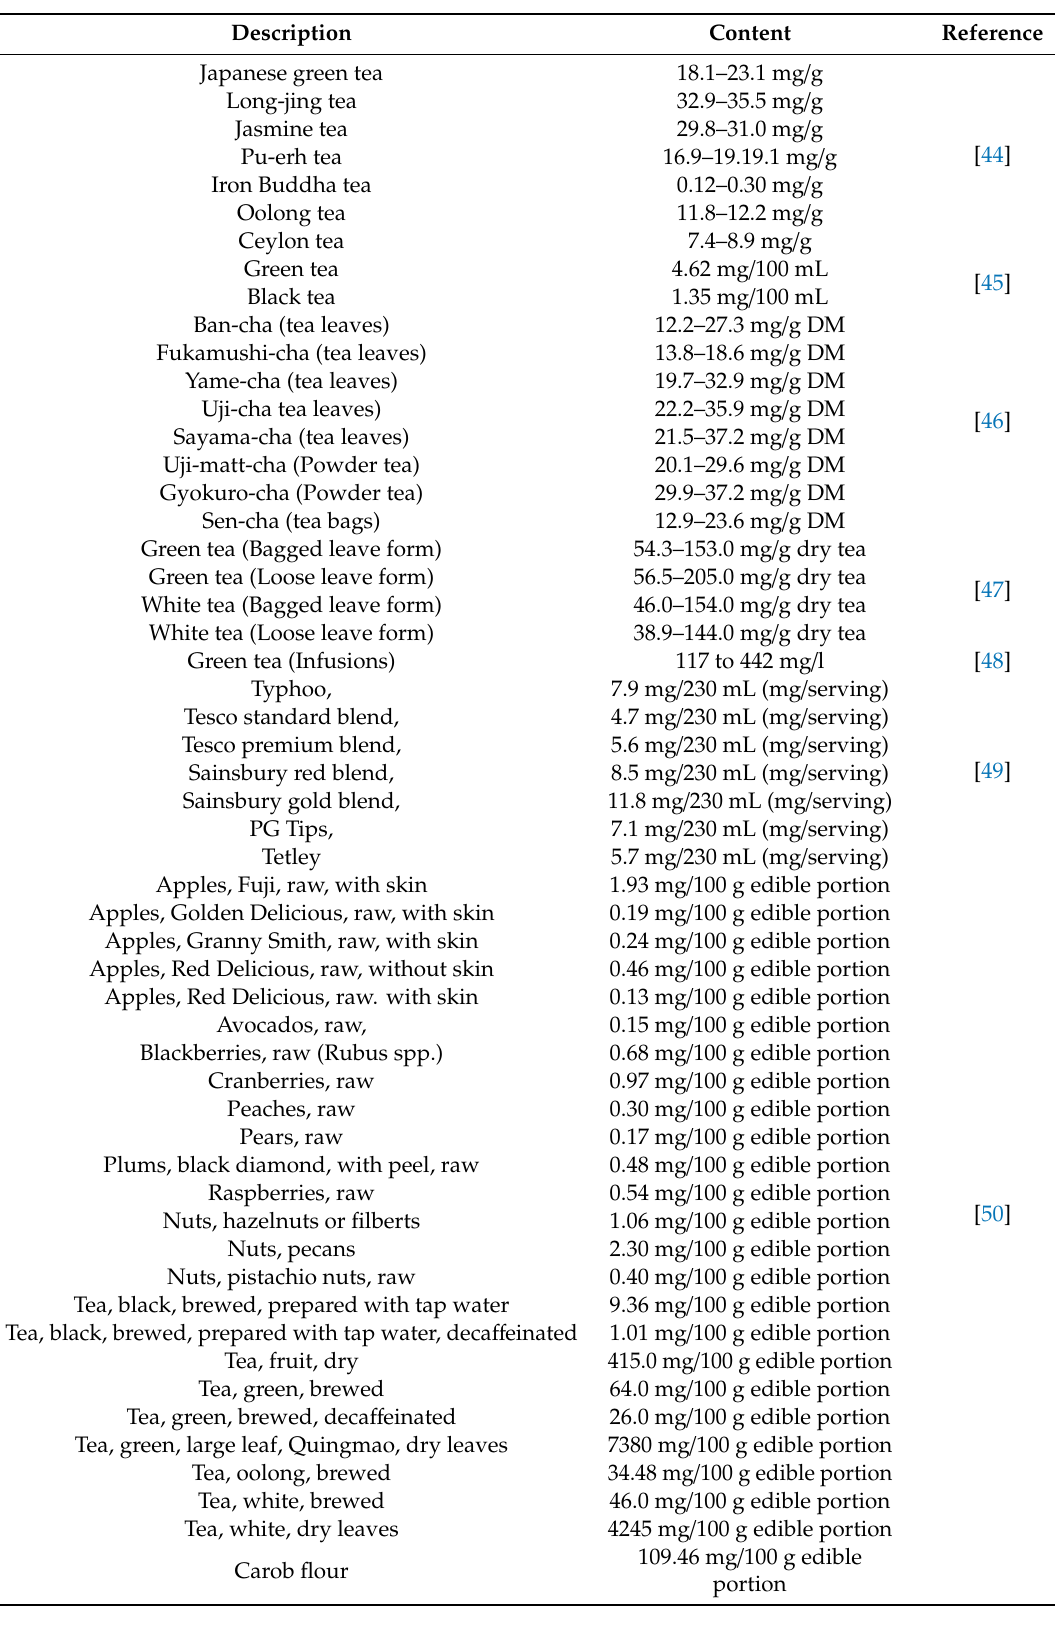
Table 1. Occurrence of epigallocatechin-3-gallate in di ff erent